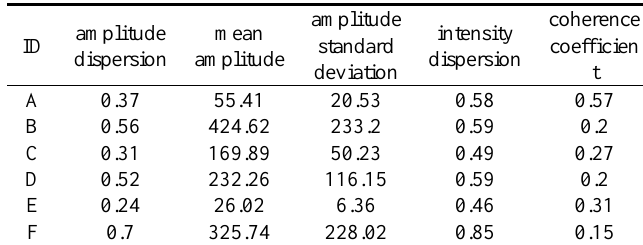
Table 1. The attribute values of PS